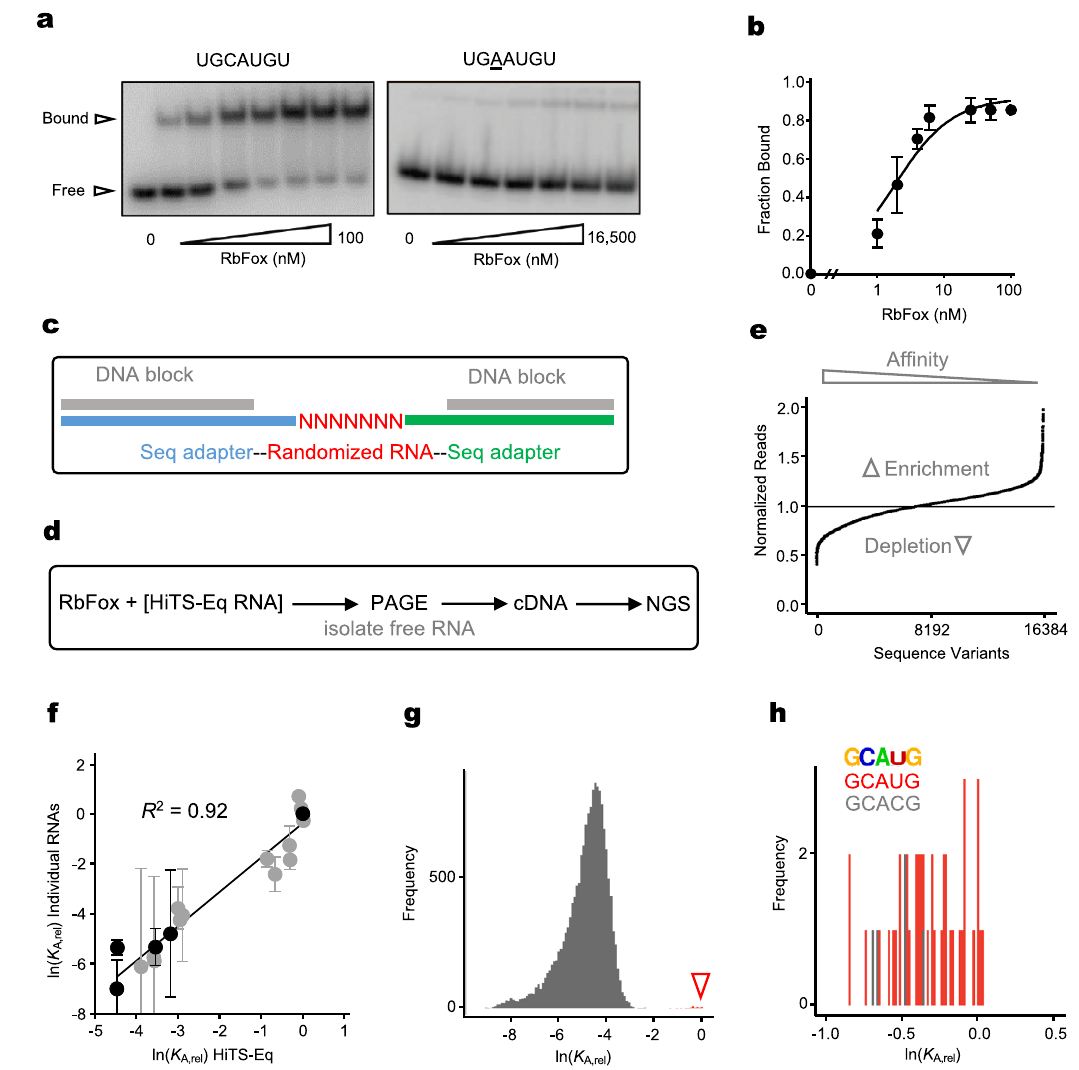
Fig. 1 | RbFox binding to all 7-mer RNA sequence variants. a Representative PAGE images for RbFox binding to individual RNA substrates under equilibrium conditions. (RbFox: 0, 1, 2, 4, 6, 25, 50 and 100nM for 5 ’ -UGCAUGU, underline marks the consensus 5-mer; 258, 516, 1,031, 2,063, 4,125, 8,250 and 16,500nM for 5 ’ -UGAAUGU, RNAs: 1nM). Data were replicated independently three times with similarresults. b Binding isothermfor5 ’ -UGCAUGU (datapoints:average ofthree independent experiments; error bars: one standard deviation; line: best fi t to binding isotherm with K 1 = 2 ð UGCAUGU Þ =1.6±0.3nM). The low level of RbFox bind- ing to 5 ’ -UGAAUGU (panel a ) precludes reliable af fi nity determination